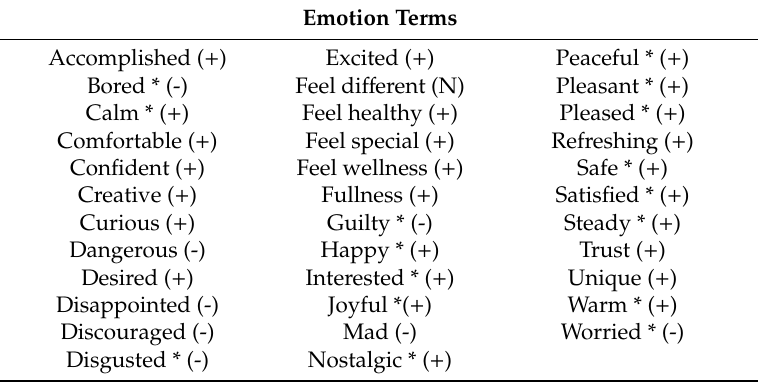
Table 1. Emotion terms (35) elicited by ready-to-eat (RTE) salads, as generated by the modified individual sample description technique